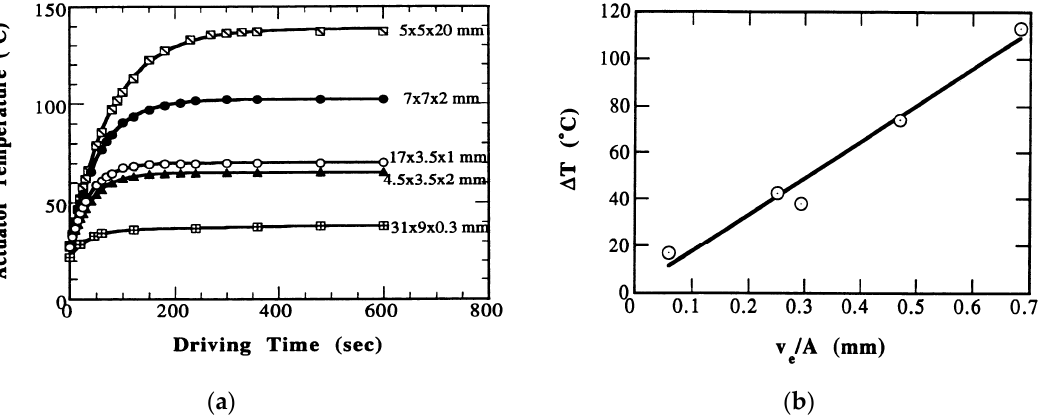
Figure 13. Structure of a multilayer piezoelectric actuator.